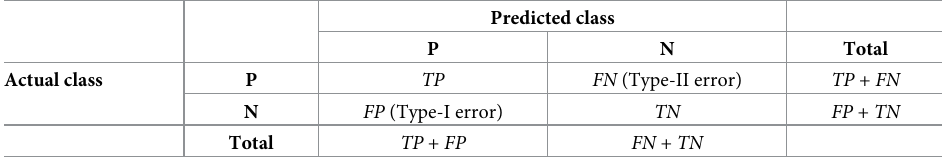
Table 3. Example of confusion matrix for a dichotomous binary classification